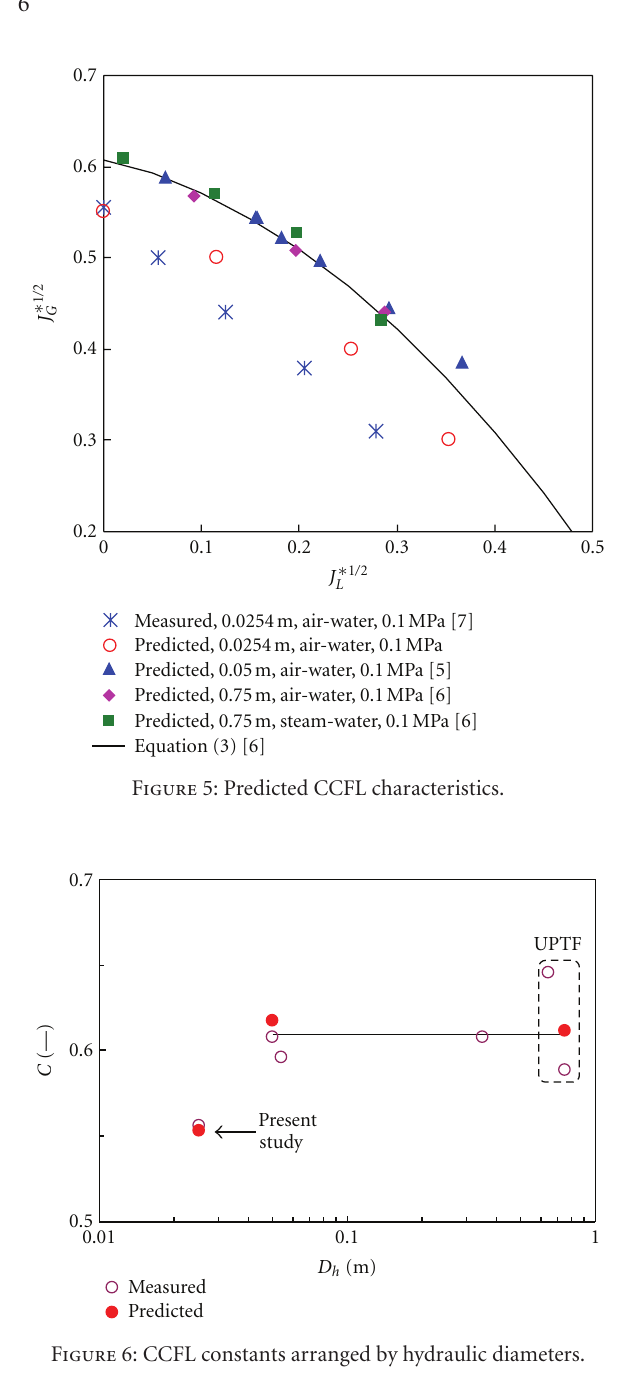
constants of hot leg models in the wide range of D h = 0 . 0254m to 0.75